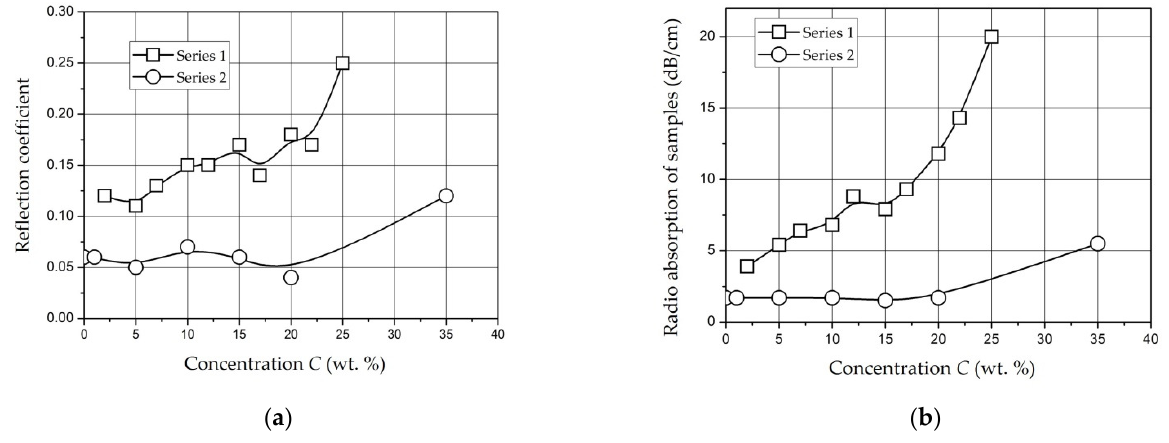
Figure 31. Dependence of ( a ) the reflection coefficients and ( b ) the specific radio absorption of samples on the mass concentration of iron in the composite.